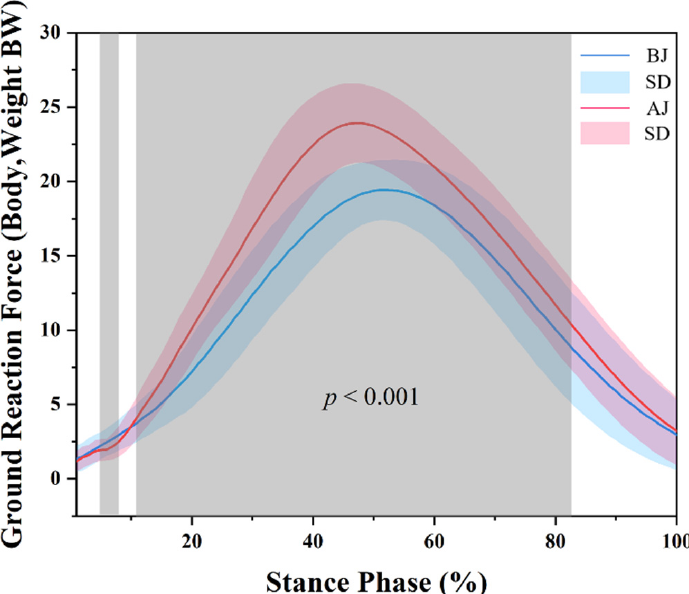
Figure 4. The statistical parametric mapping (SPM) results between bounced jump (BJ) and alternate jump (AJ) tasks following a spike, depicting the mean vertical ground reaction force (VGRF) and standard deviation. Grey shaded areas indicate significant differences between BJ and AJ during the ground-contact phase ( p < 0.05).